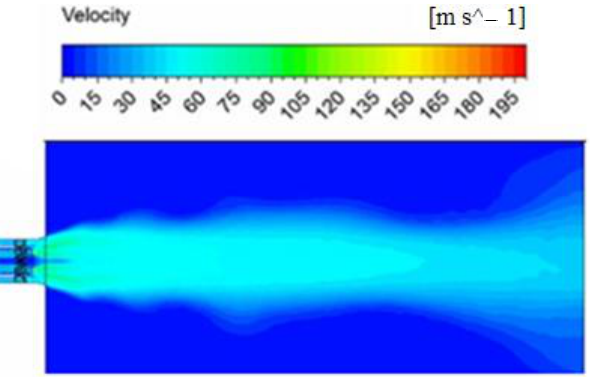
Figure 14. An example of a stepped approximation of nonperiodic functions.